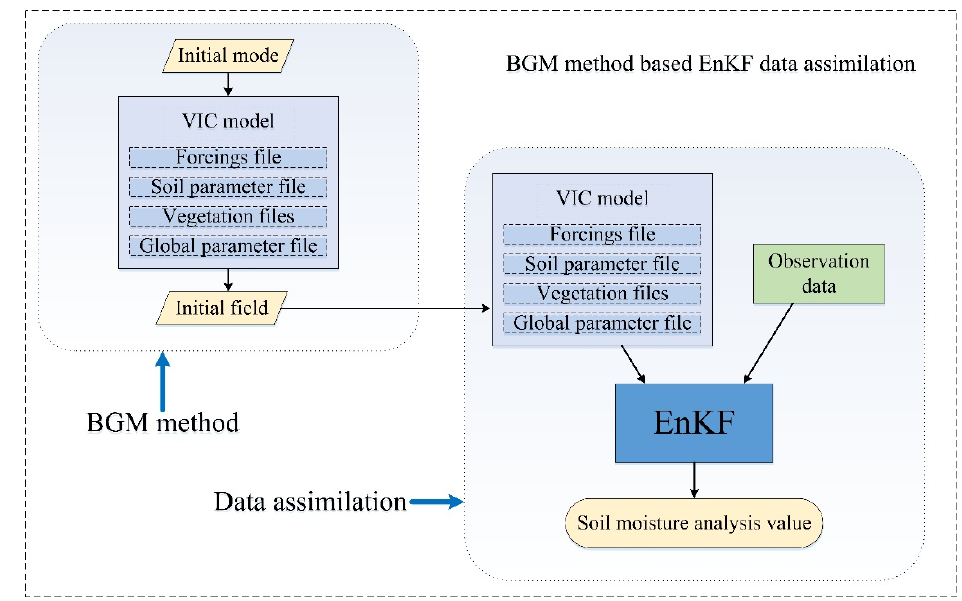
Figure 1. The theoretical framework of the ensemble Kalman filter (EnKF) data assimilation based on the breeding of growing mode (BGM) method. Variable infiltration capacity (VIC) model indicates the variable infiltration capacity model.